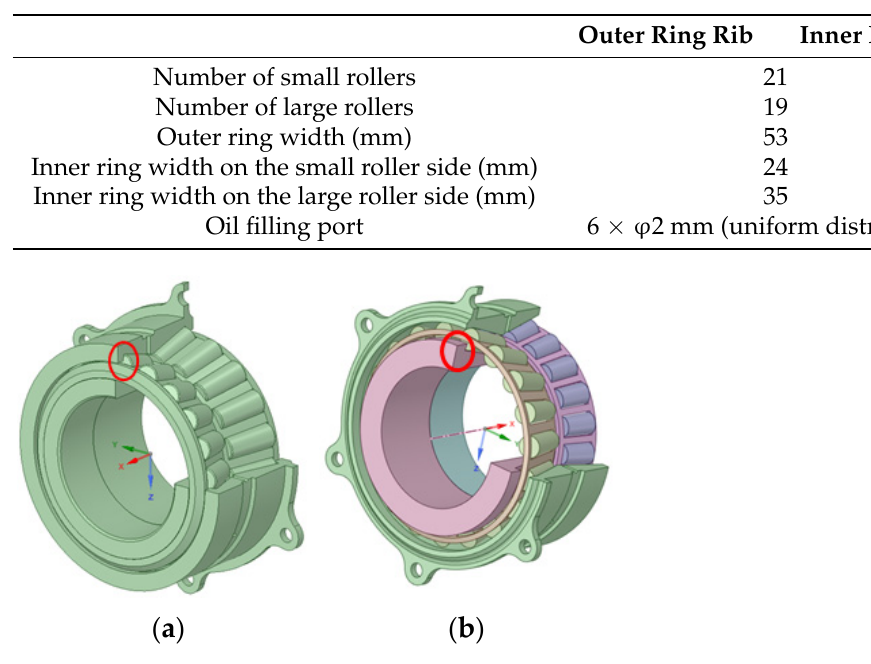
Table 1. Main parameters of double-row TBRs.